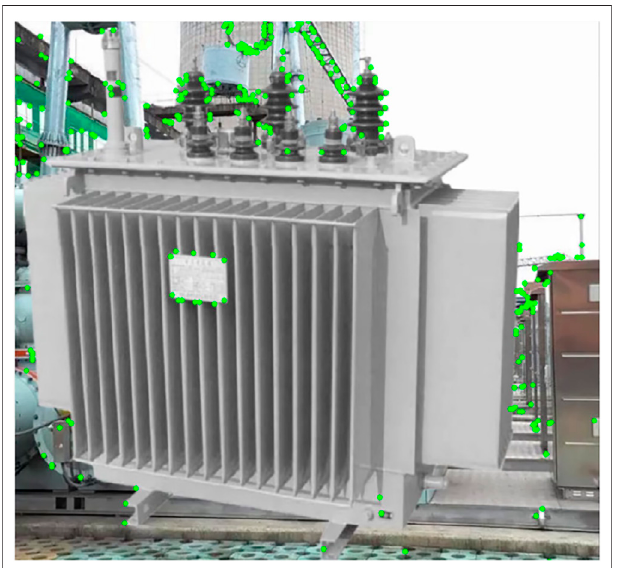
FIGURE 9 | The feature points in the whole image area are represented by green dots. The peripheral feature points of the transformer will interfere with the calculation of the transformer vibration vector.